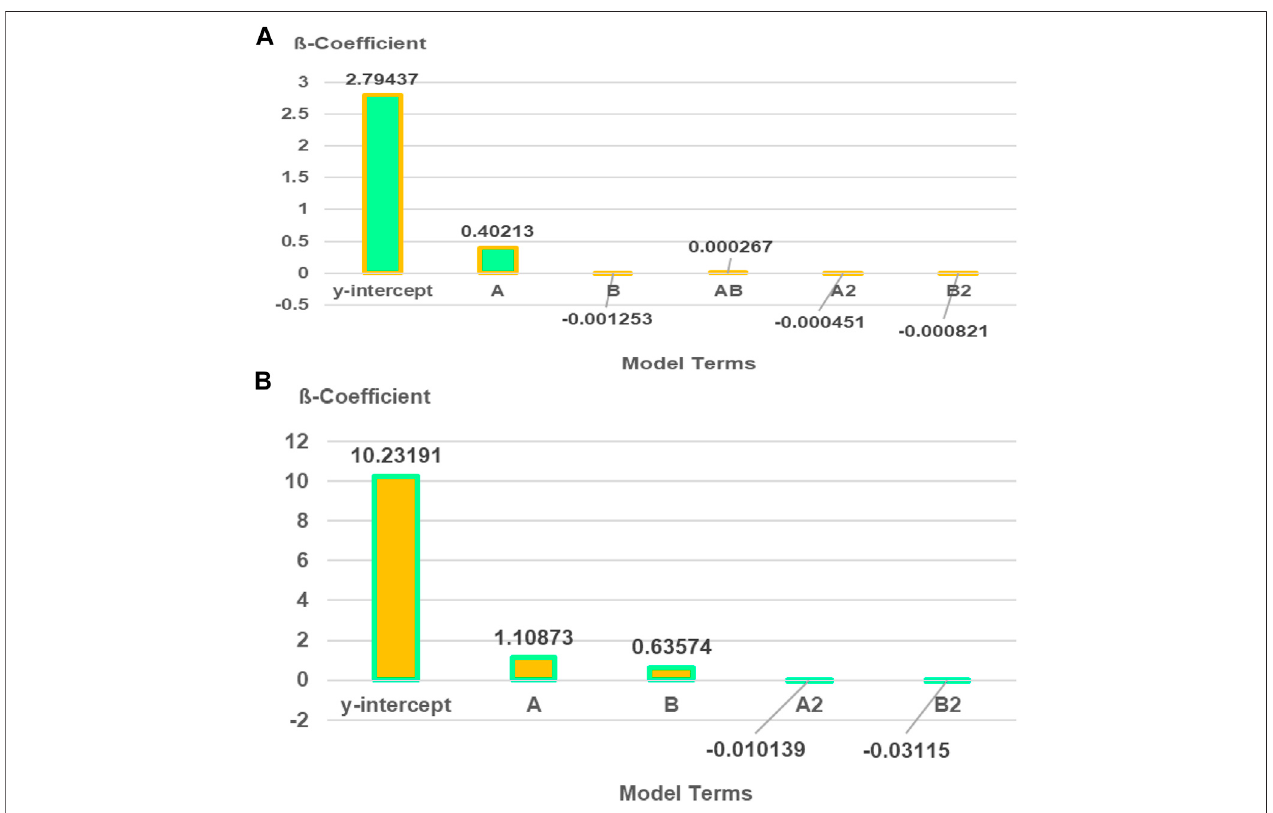
FIGURE 9 | β coef fi cient of actual factors for quadratic models: (A) Mix 75 and (B) Mix 100.